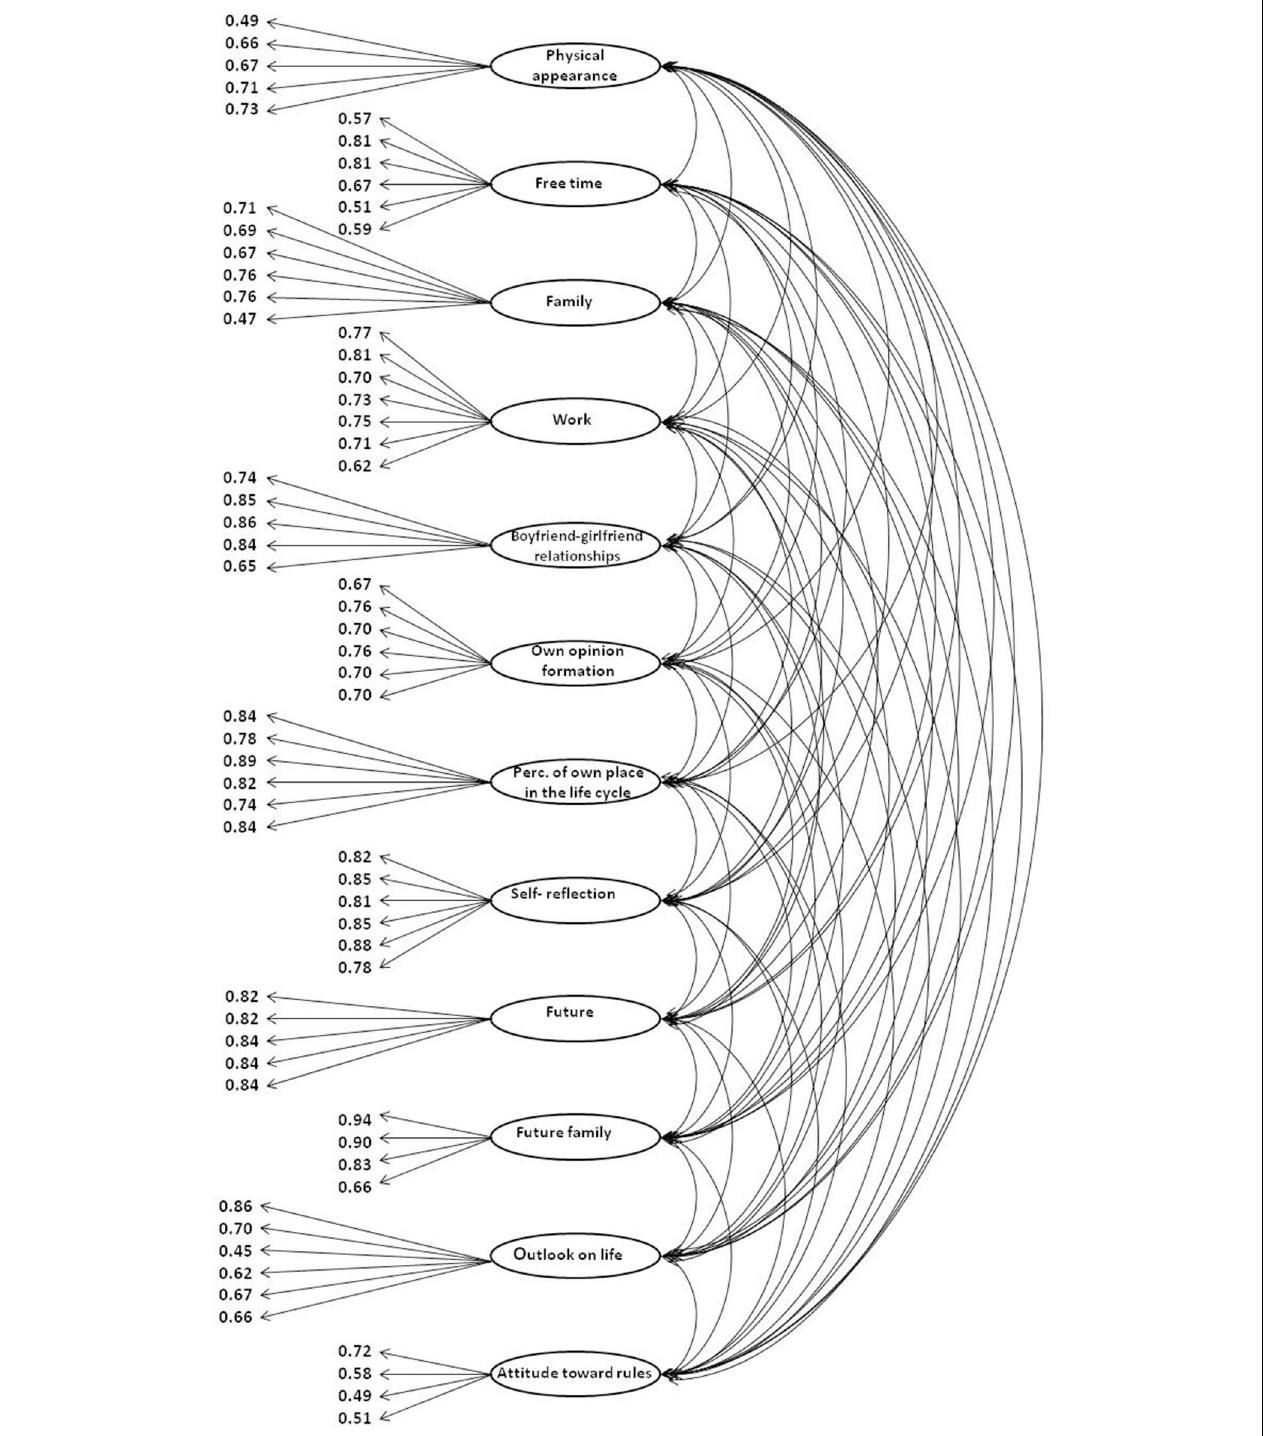
FIGURE 1 | Confirmatory factor analysis of the Early Identity Exploration